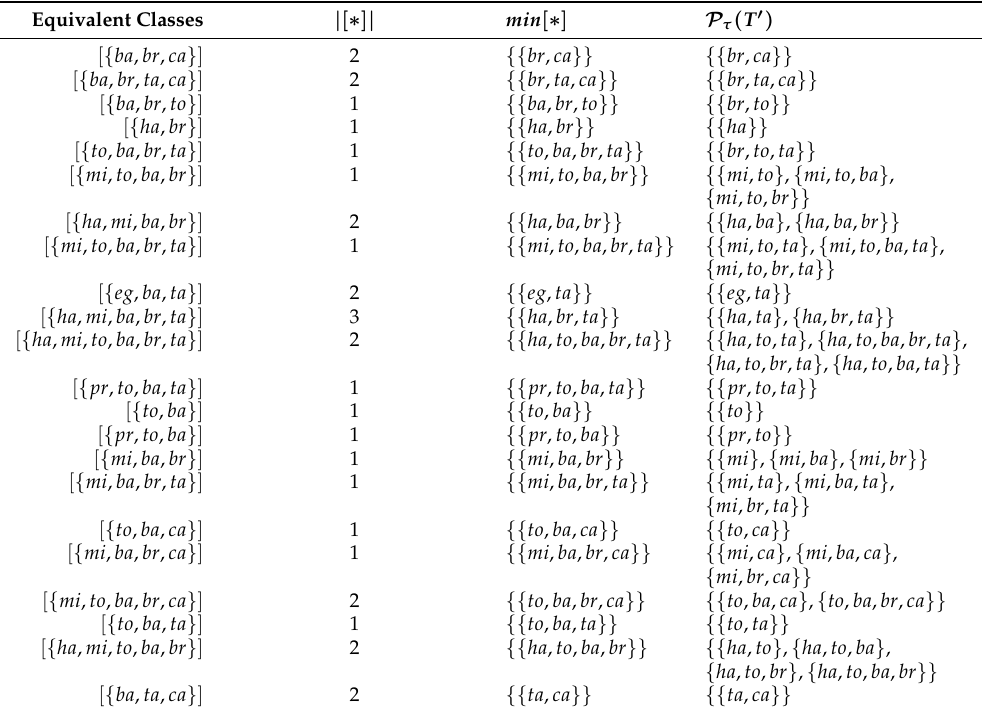
Table A3. Equivalent classes used to generate association rules with supp r ( c = 1.